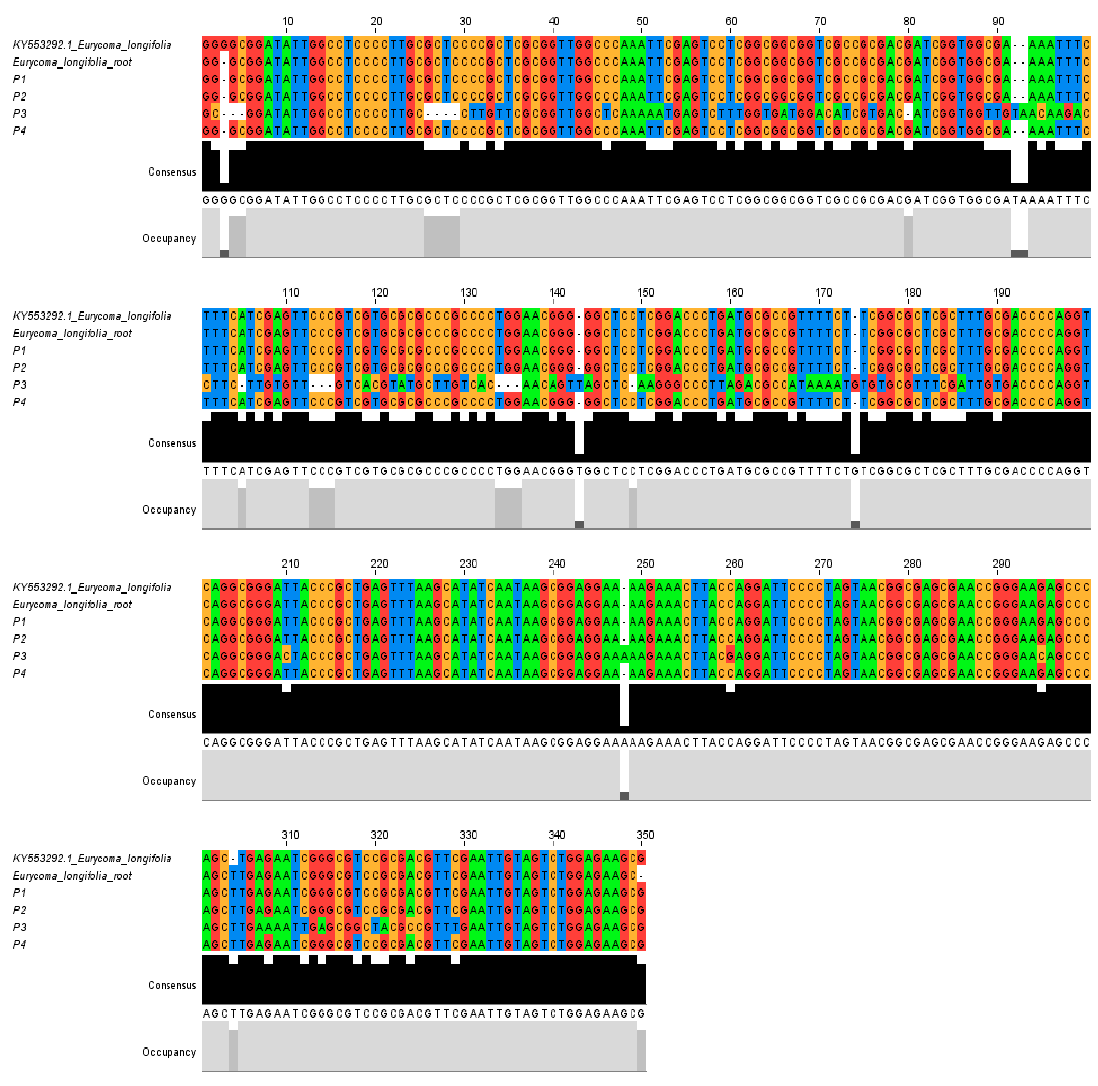
Figure 3. Multiple sequence alignment of ITS2 between KY553292.1 E. longifolia extracted from NCBI database, E. longifolia root and four commercial herbal products: P1, P2, P3 and P4.